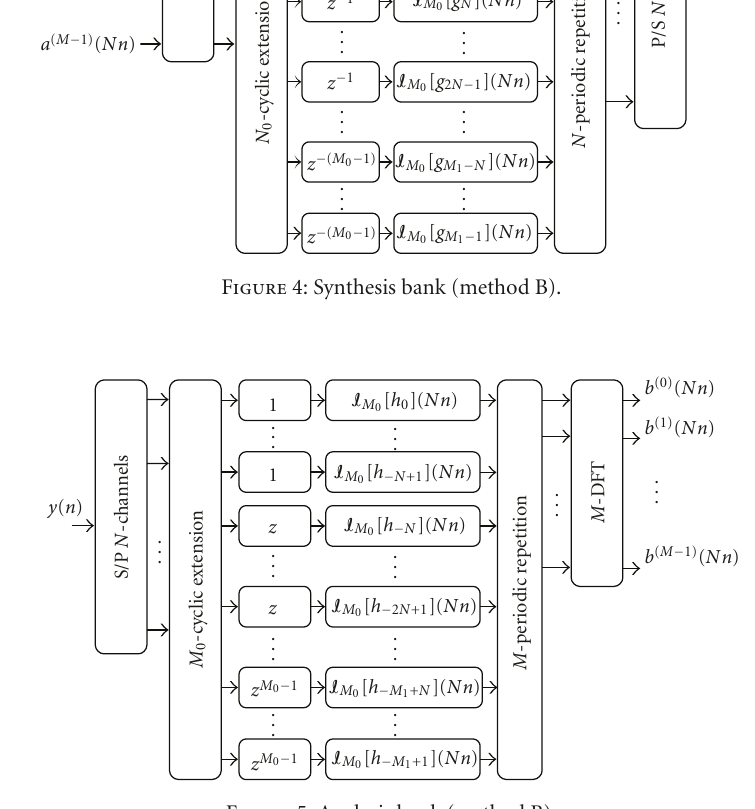
Figure 5: Analysis bank (method